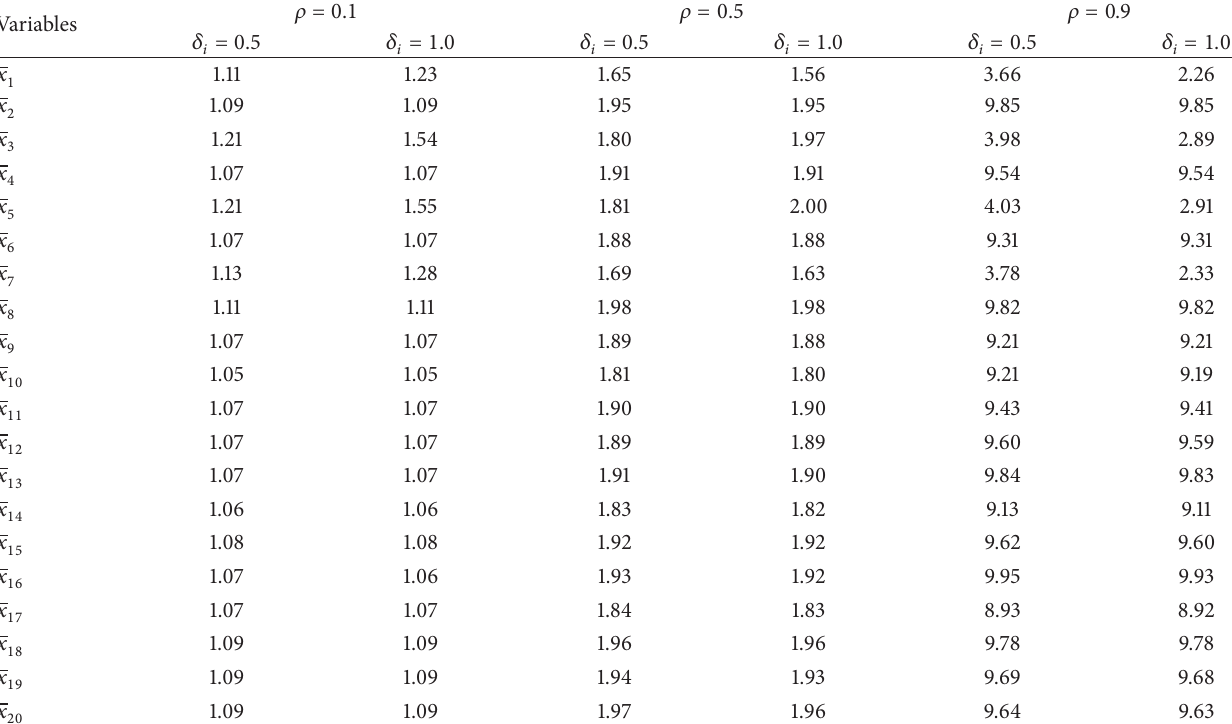
Table 1: Collinearity diagnosis for LR models.